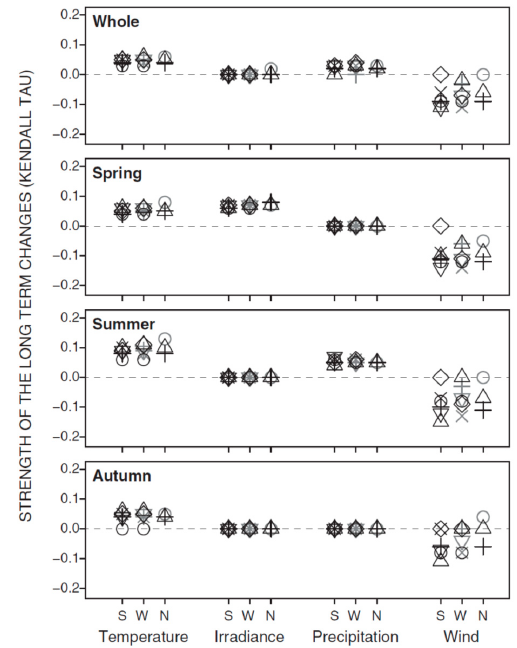
Figure A5. Summary of monotonic long ‐ term trends in climatic parameters in each lake analysed for the whole year and for separate seasons. For details see Figures 2 and 4 in the text.